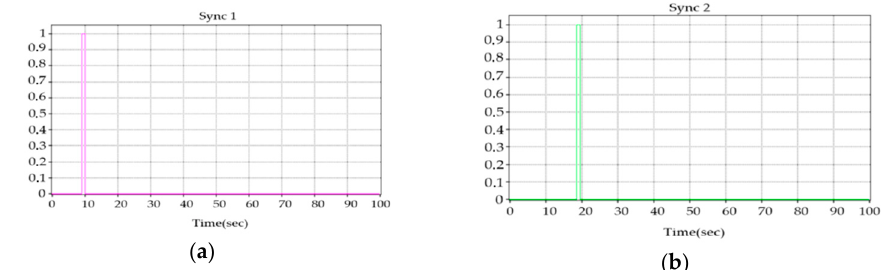
Figure 9. Synchronisation signals: ( a ) Sync1; ( b )Sync2 (see Figure 6).